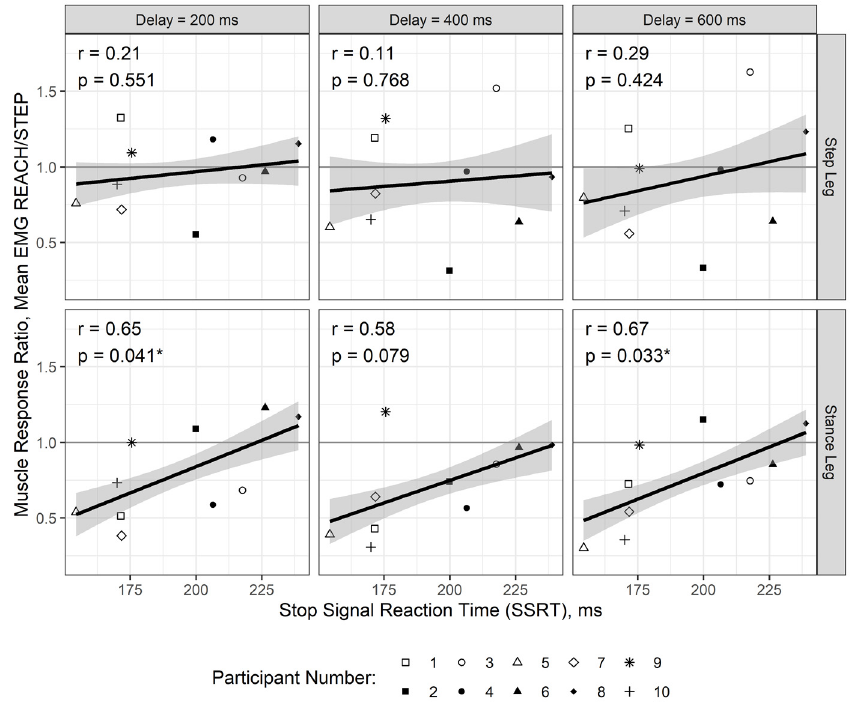
Figure 2. Observed aggregated muscle response ratios and stop signal reaction time by post-visual preview delay and leg. Each panel reports Pearson’s correlation among the ten observations with overlaid, independently-run linear regression and 95% confidence band. This figure is intended as a descriptive summary (n participants = 10). * p < 0.05